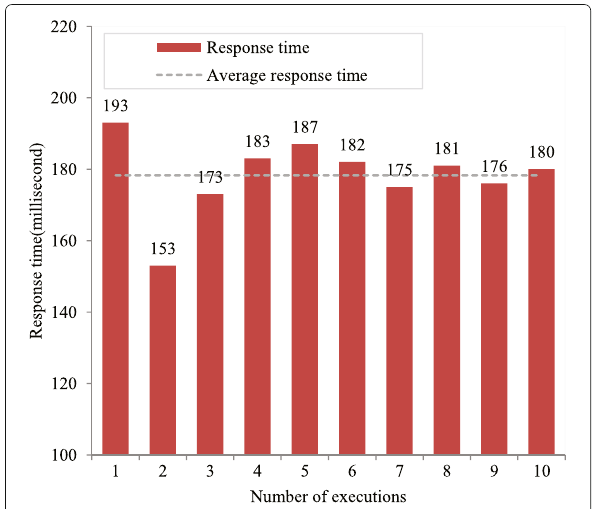
Fig. 9 Service performance of NFP for multidimensional time sequence